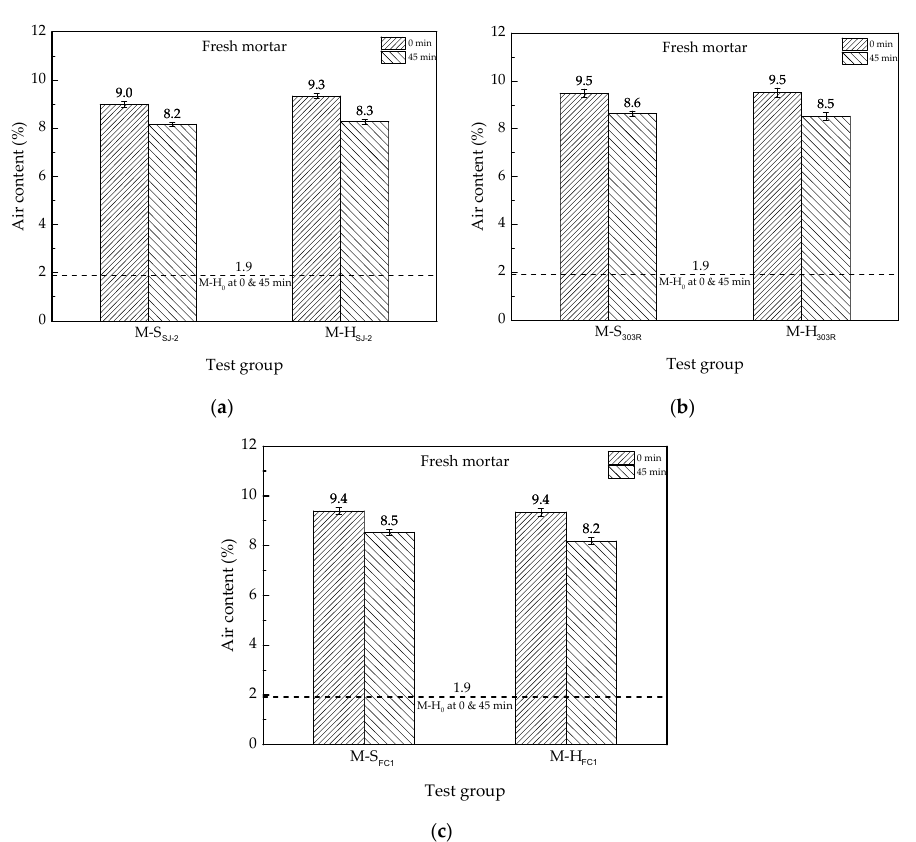
Figure 2. Air contents of fresh mortar prepared in two different atmospheric pressures: ( a ) with SJ-2; ( b ) with 303; and ( c ) with FC1.